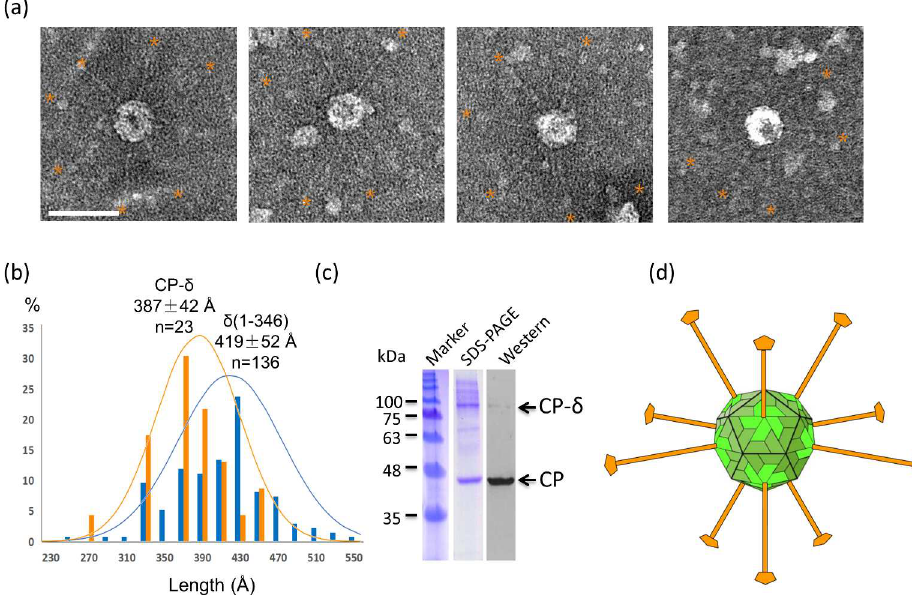
Fig 5. CP- δ forms particle associatedfibers. (a) EM images of Orsay VLPs containing CP- δ . Protruding fibers are highlighted by orangestars. Scale bar, 500 Å . (b) Length measurements of particle-associated fibers in comparison with the full-length δ fibers. (c) SDS-PAGE of the Orsay VLP. Western blot was performed using an anti-His antibody.(d) An Orsay capsid model with CP- δ fibers situated at the five-folds. On five-fold vertices, the CP portion and the δ portion of the CP- δ are shown in light green and orange respectively. The rest of the CP moleculesin the capsid are shown in dark green. The Orsay, ~350- Å in diameter, and the CP- δ fiber, ~400- Å in length, are approximately drawn to